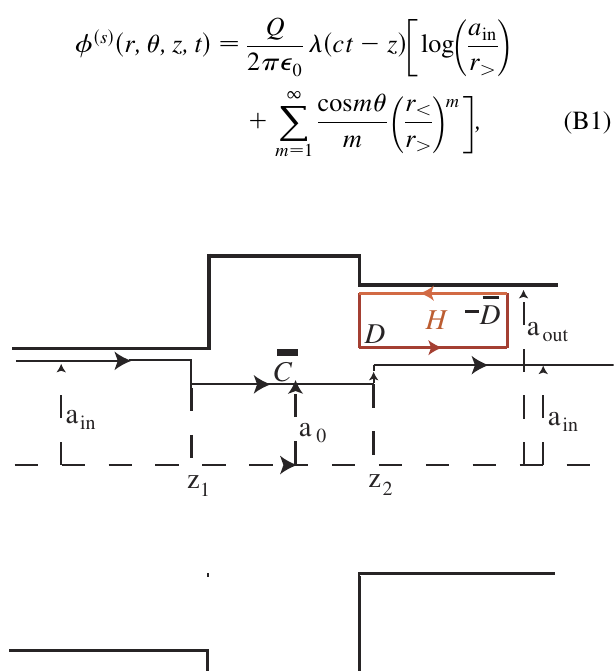
FIG. 6. (Color) The cavity and the integration path. Here the is larger than that of the tube radius of the downstream side a out . The longitudinal coordinate z and z and the upstream side a in 1 2 specify the contour (cid:1) C . The contour H defines radial coordinate a 0 the loop path described in the red line.